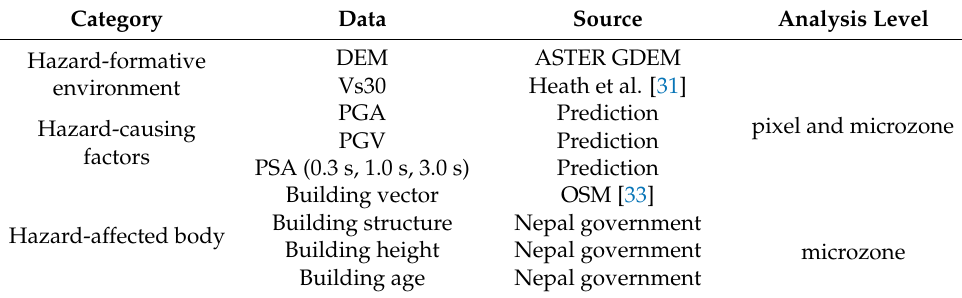
Table 1. Different categories of data and applied analysis levels.